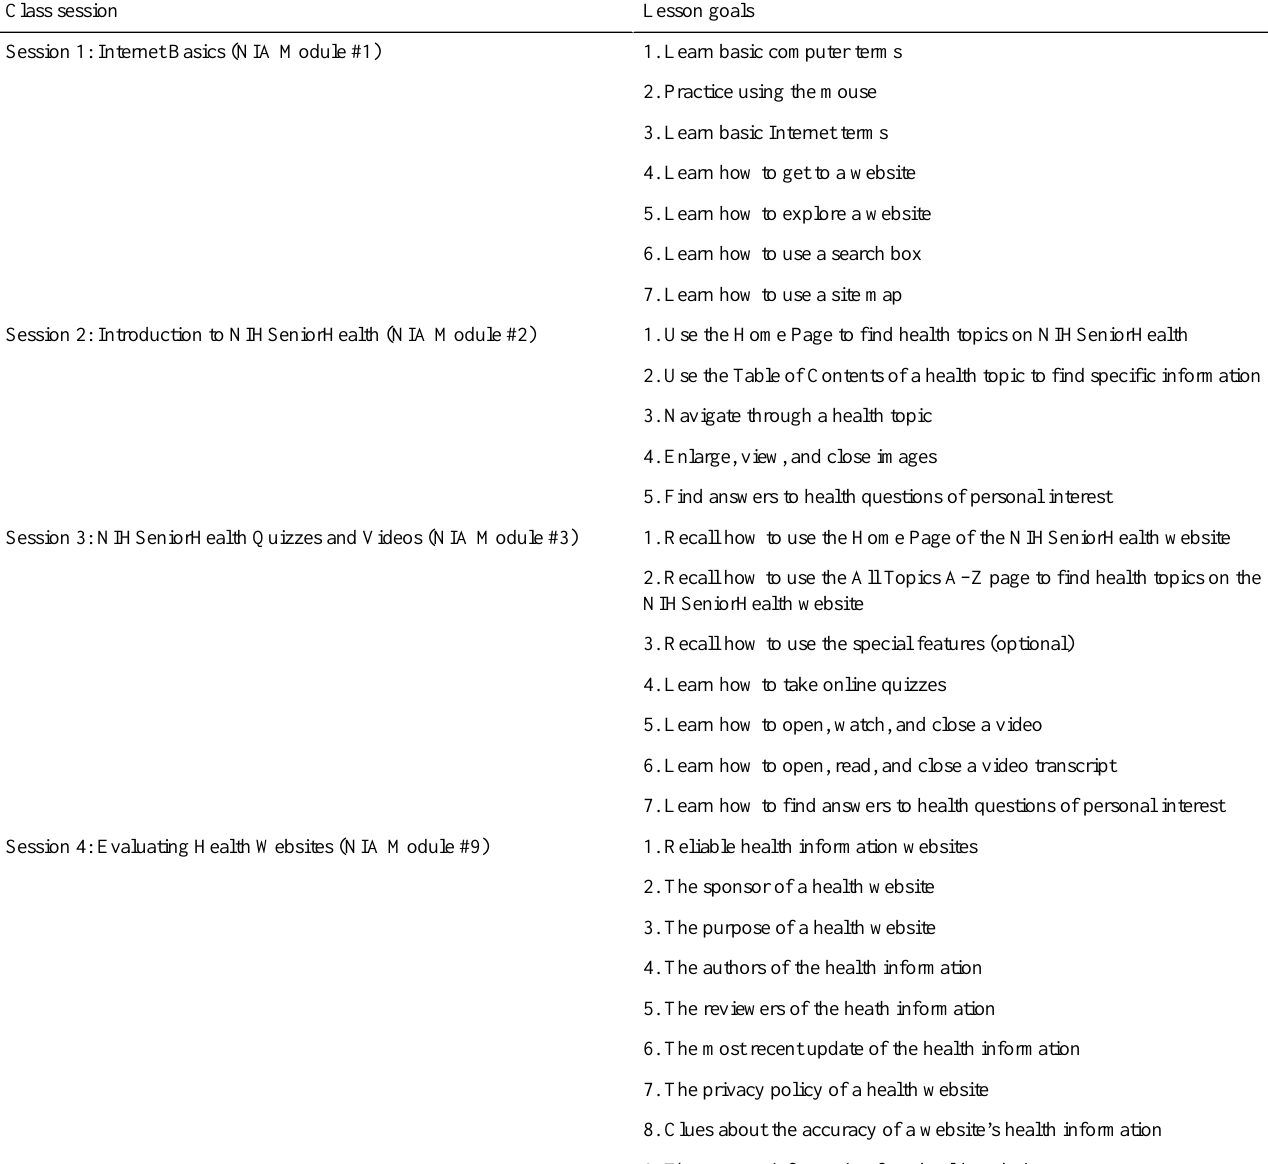
Table 3. Lesson plans and goals included in the National Institute on Aging (NIA) toolkit (extracted from the toolkit [56]).